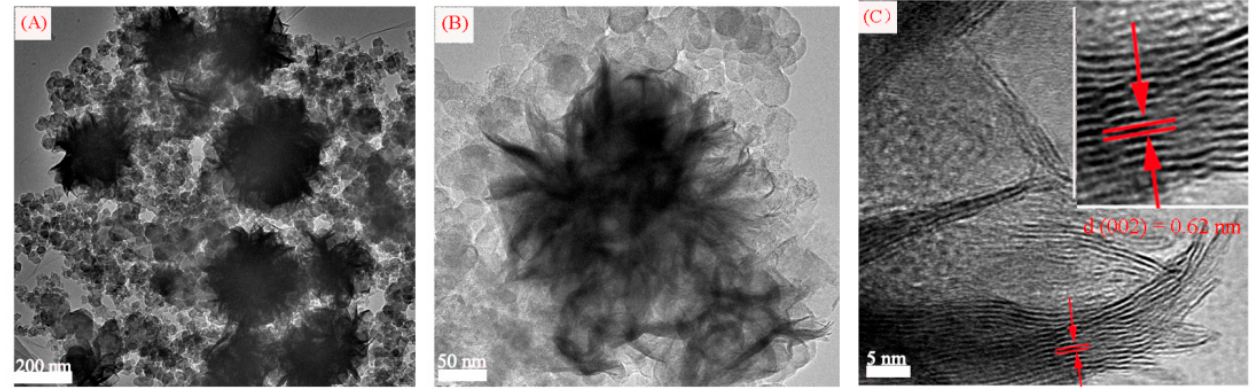
Figure 3. TEM images of MoS 2 /C nanocomposites at different magnification ( A – C ). The inset is the HRTEM image.